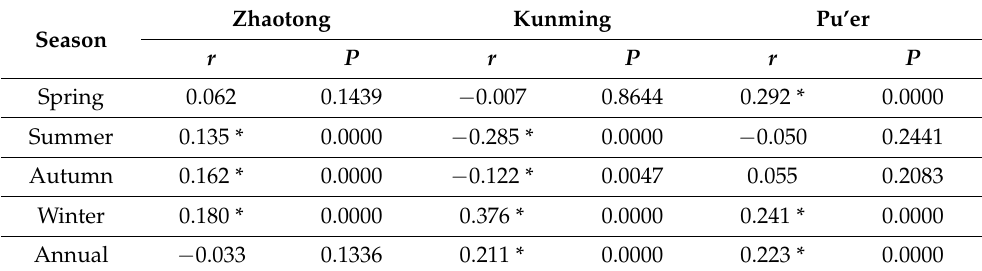
Table 3. Correlation Analysis of O 3 Concentration and Wind Speed in Different Seasons.